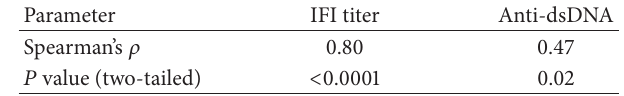
Table3:ANAscreeningagreementbetweenvisualandICAREeval- uations. ICARE+ ICARE − Total Visual+